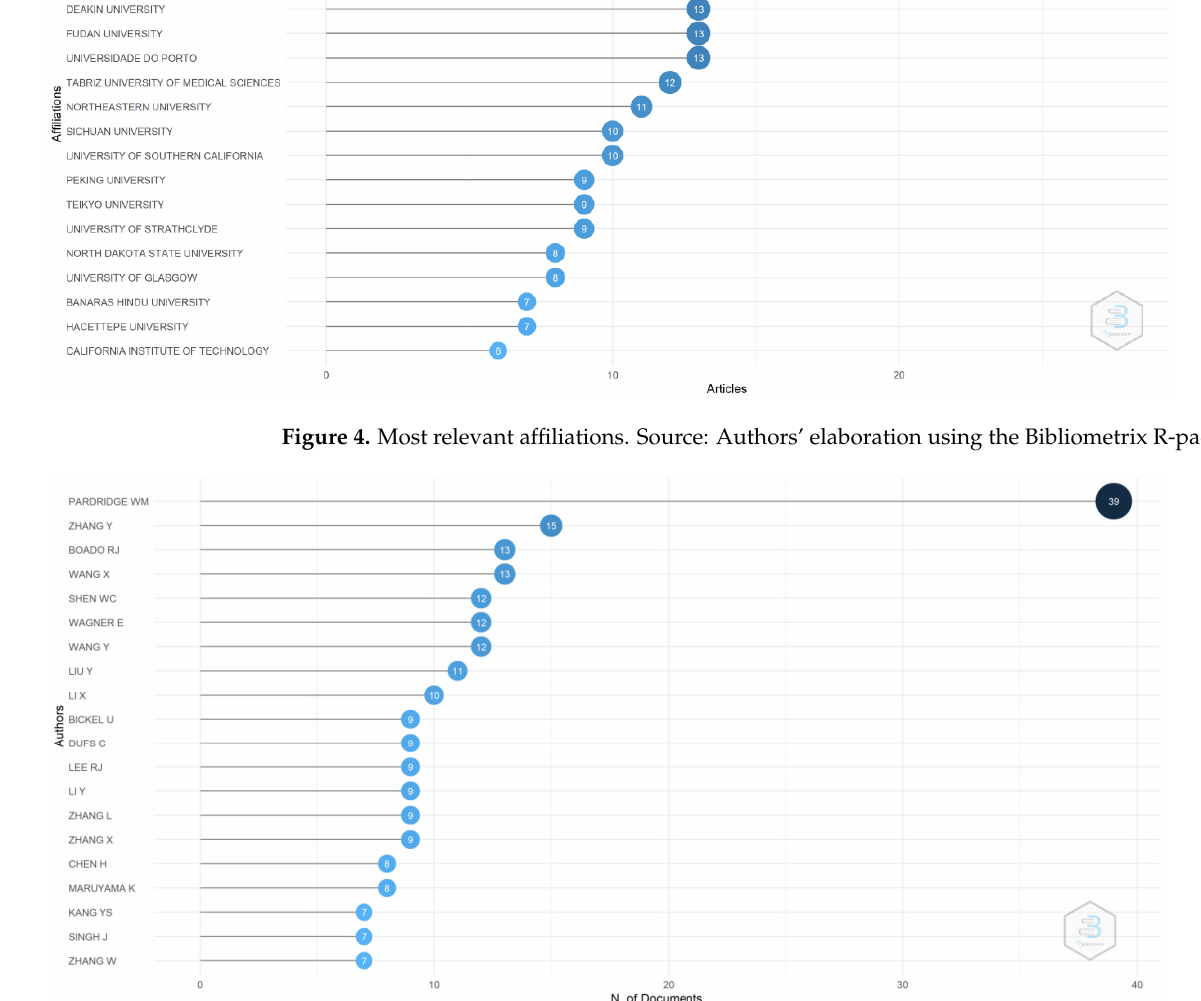
Figure 4. Most relevant affiliations. Source: Authors’ elaboration using the Bibliometrix R-package.